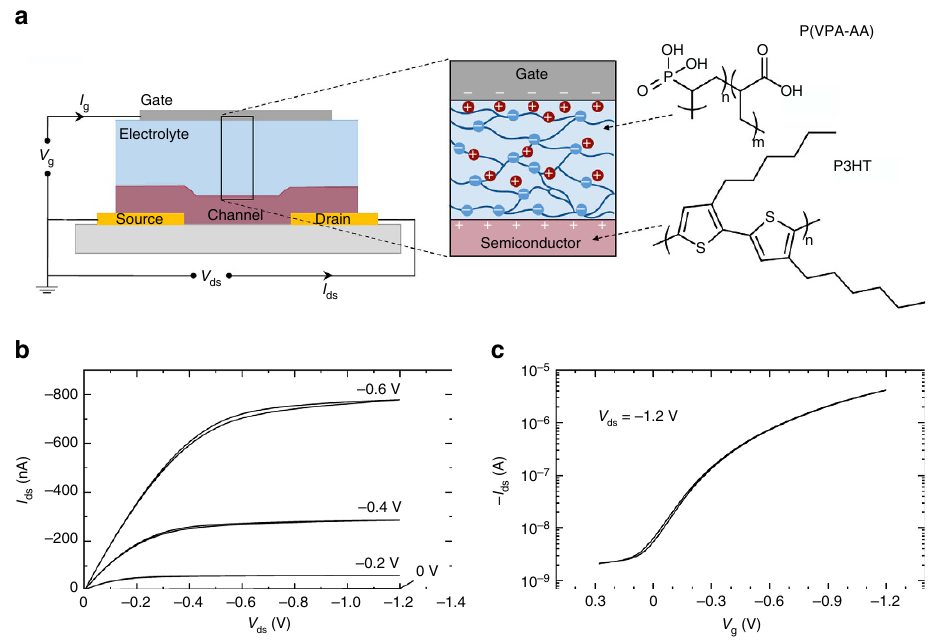
Figure 1 | Electrical characteristics of an electrolyte-gated transistor. Schematic diagram of an electrolyte-gated transistor and illustration of the channel charge and ion distribution within the electrolyte layer. The chemical structures of P3HT and P(VPA-AA) are also reported ( a ). Representative output characteristics of the P3HT-based electrolyte-gated transistor (Ti gate metal, L ¼ 10 m m, W ¼ 1mm) ( b ). Corresponding transfer characteristics at V ds ¼ (cid:2) 1.2V ( c